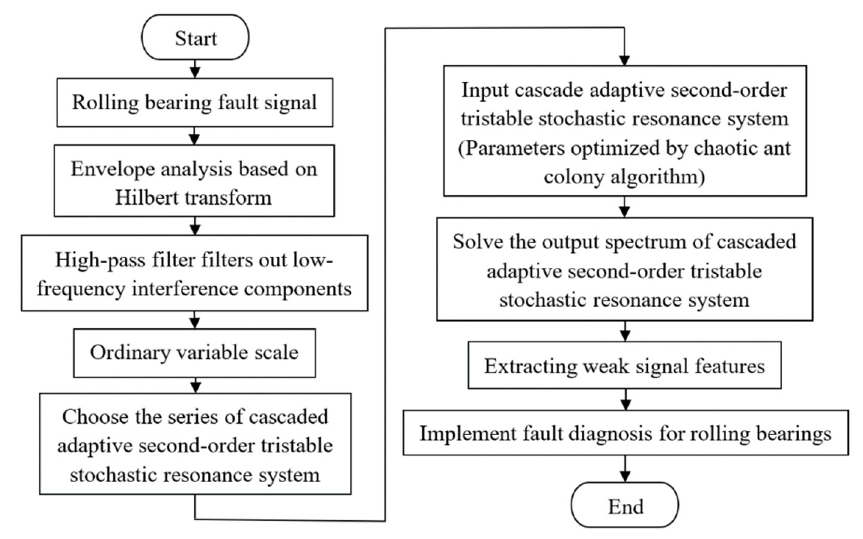
Figure 3. The detailed fault diagnosis process based on CASTSR for rolling bearings.